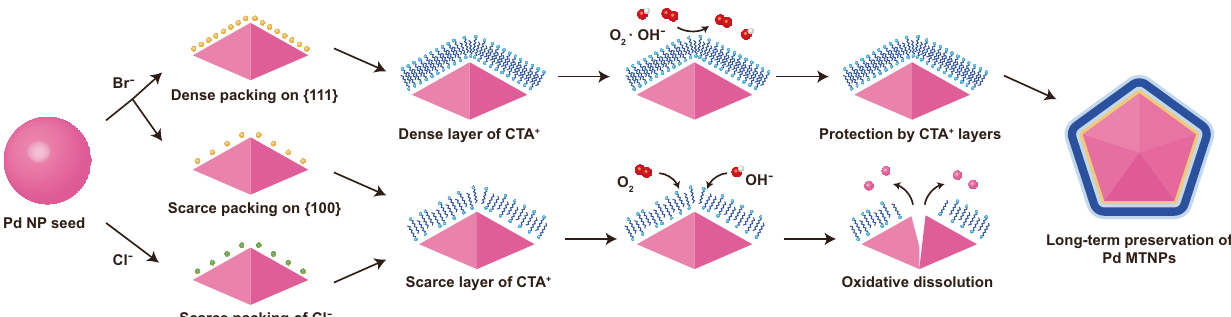
Fig. 5 In fl uence of halide anions and CTA + on the shape and oxidation stability of Pd NPs and MTNPs. The density of Br – adsorbed on the Pd {111} facets is high, enhancing adsorption of CTA + through electrostatic forces and thereby yielding Pd MTNPs of high oxidation resistance. In contrast, the density of adsorbed Cl – is comparatively low, resulting in low adsorption of CTA + and oxidative etching of the